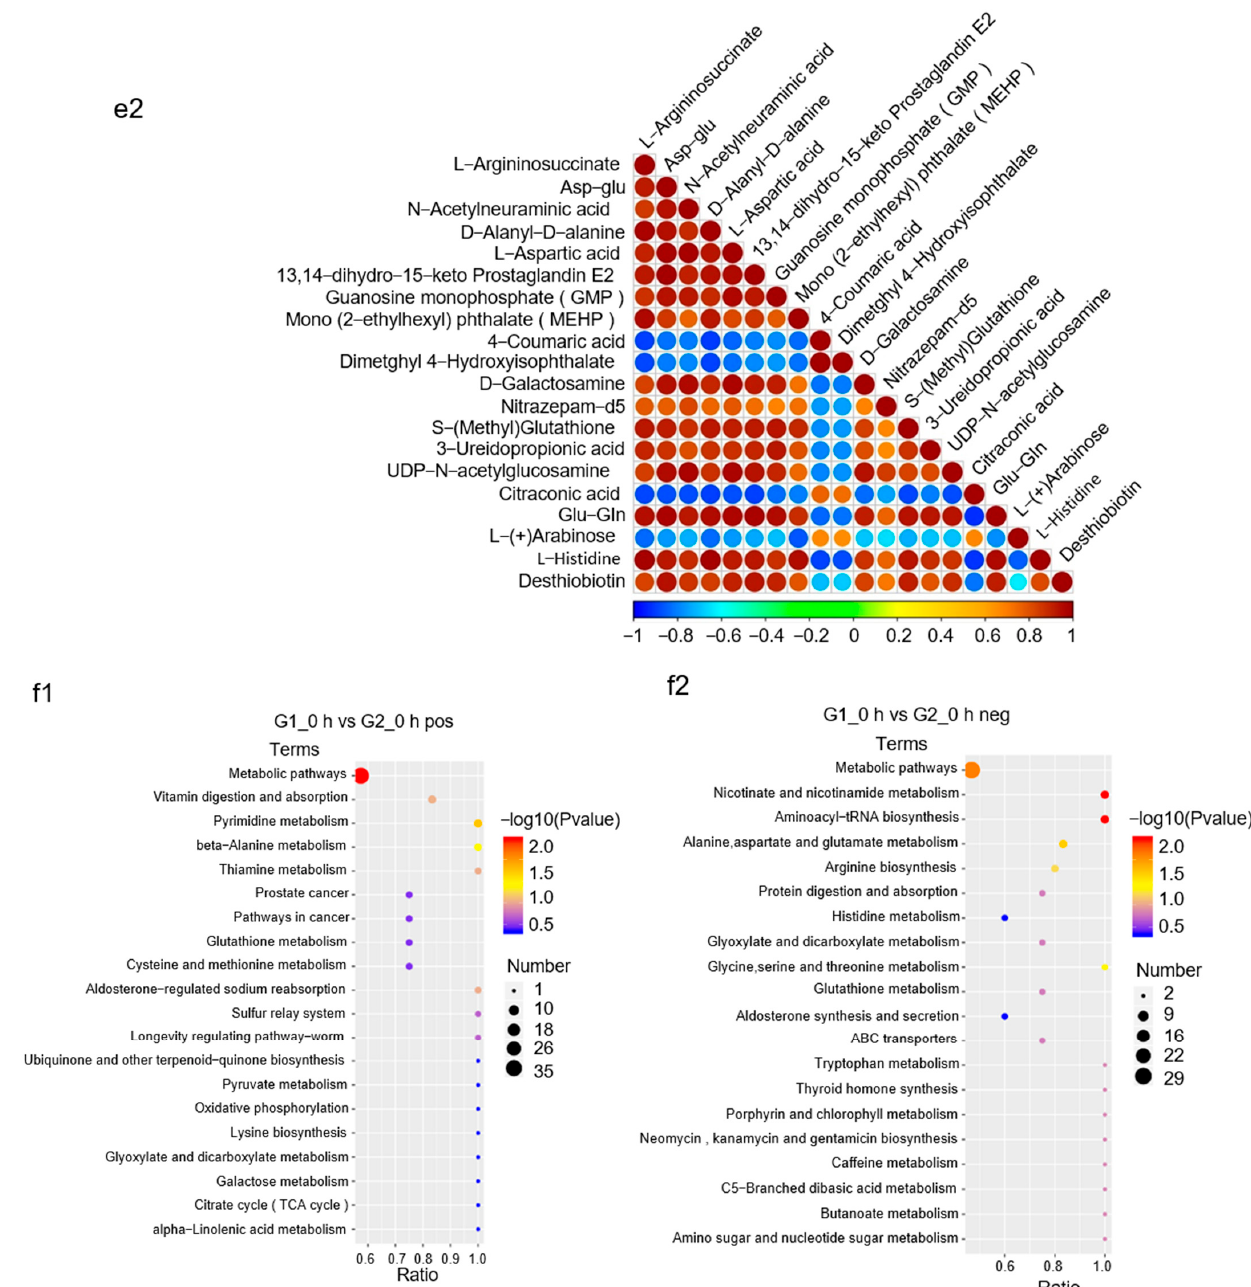
Figure 5. Metabolomics analysis of animal-based enzymes and animal-origin-free enzymes. ( a ) Cor- relation analysis diagram of quality control (QC) samples. Pearson correlation coefficient between QC samples was calculated based on the relative quantitative values of metabolites. ( a1 ) is the Pearson correlation coefficient between seven groups of data QC samples in positive ion mode. ( a2 ) is the Pearson correlation coefficient between seven groups of data QC samples in positive ion mode. Pearson correlation coefficient between seven groups of data QC samples. ( b ) PCA analysis diagram of total samples. The peaks extracted from all the experimental samples and QC samples were ana- lyzed using PCA. In the figure, the abscissa PC1 and ordinate PC2 represent the scores of the first and second principal components, respectively; the scatter points of different colors represent sam- ples in different experimental groups; and the ellipse represents the 95% confidence interval. ( b1 ) is the PCA analysis diagram of the total sample in the positive ion mode, and ( b2 ) is the PCA analysis diagram of the total sample in the negative ion mode. ( c ) Differential metabolite clustering heat map.